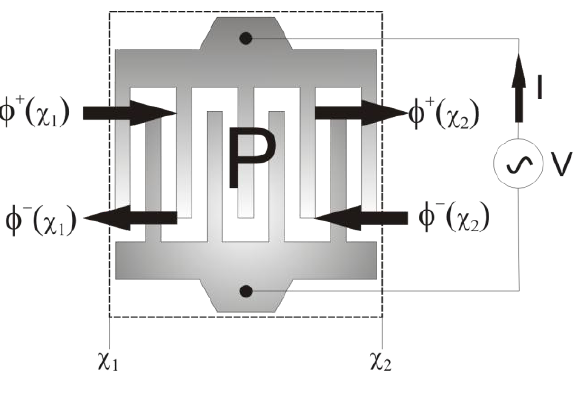
Figure 1. Representation of an IDT structure as a three port